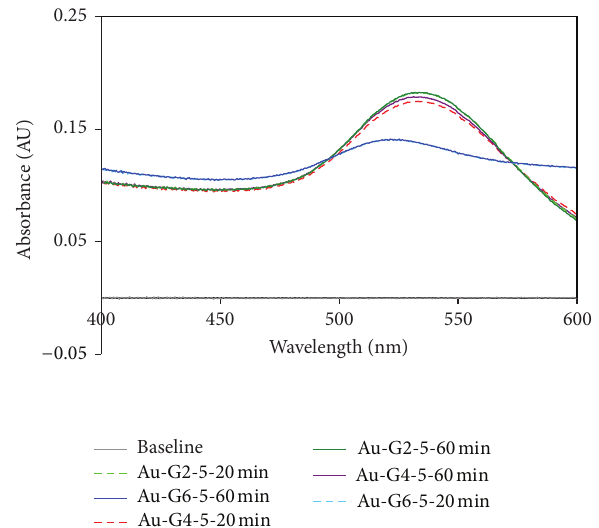
Figure1:HypsochromicshiftoftheSPRsignalofgoldnanoparticles Au-Gi-5, due to increasing the generation of dendrimers from G2 to G6. The spectra recorded after 20 minutes and after 60 minutes, respectively, (from the moment when the dendrimers and gold precursors were mixed) show good stability of the nanoparticles in the first reaction